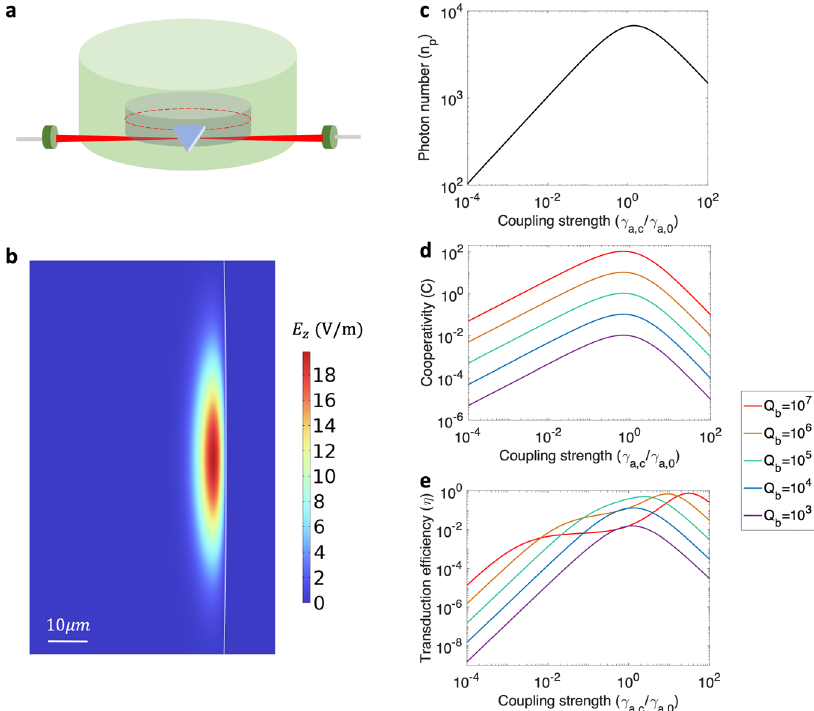
Fig. 3 Optical design for quantum transduction. a Schematic diagram of the optical coupling scheme with a prism coupler. The optical pump and signal are focused onto the prism coupler via a microlens. The re fl ected light is collected by another microlens. b Whispering gallery mode in the LN optical resonator. The white lines show the boundary of the LN resonator. c Photon number in the pump mode versus the coupling strength between the prism and the optical resonator ( γ a , c normalized by the intrinsic optical loss rate γ a ,0 ). d Cooperativity and e transduction ef fi ciency versus the resonator-prism coupling for different quality factors of the microwave cavity ( Q b ). Parameters: Q a = 10 7 , Q b = 10 5 , γ b , c = 3.4 × γ b ,0 , g eo = 2 π × 46.75 Hz, δ p = 10